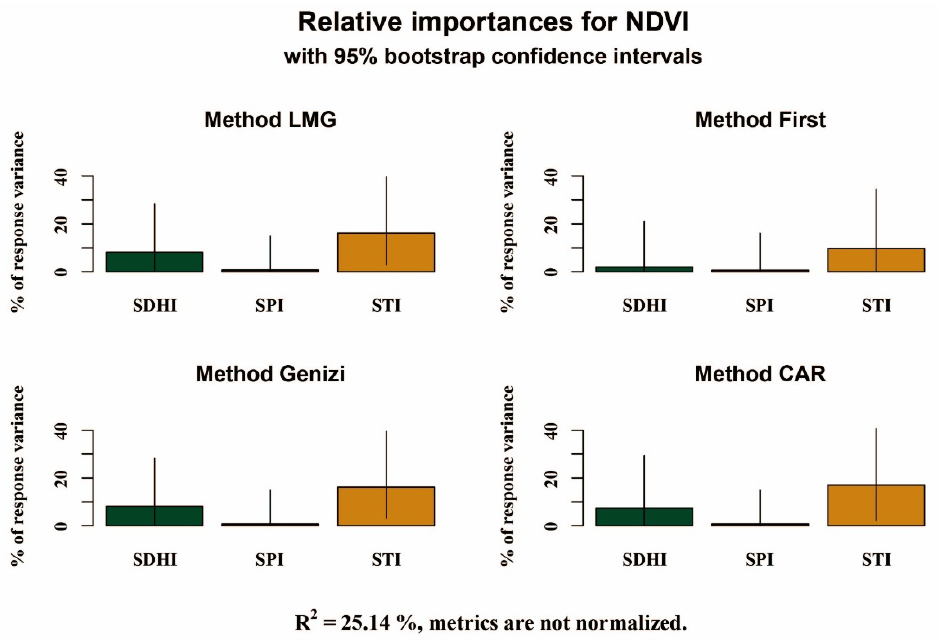
Figure 11. Analysis of the relative importance of SPI, STI, and SDHI to NDVI in Inner Mongolia .